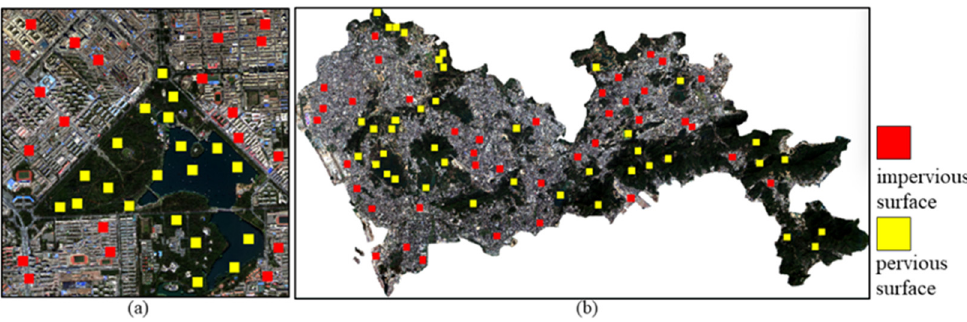
Figure 2. Training sample dataset labeling diagram: ( a ) GF-2 image samples; ( b ) Sentinel-2 image samples.